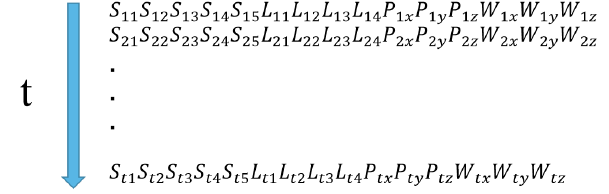
Figure 5. Multiscale hand action